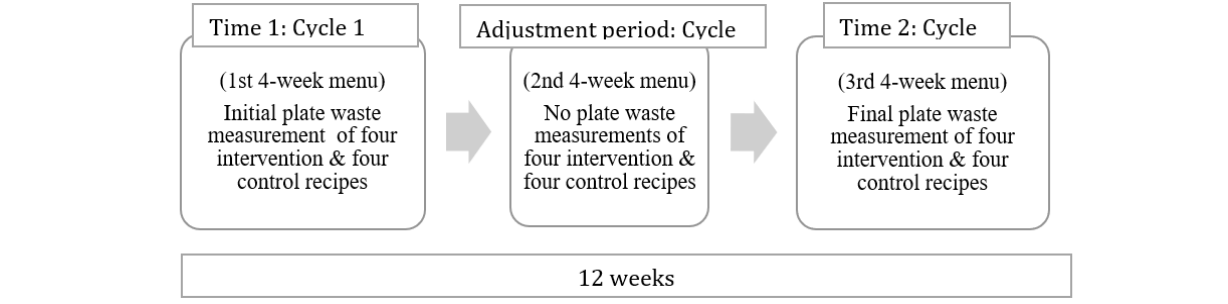
Figure 4. The plate waste measurement cycle in the Pulse Discovery Toolkit